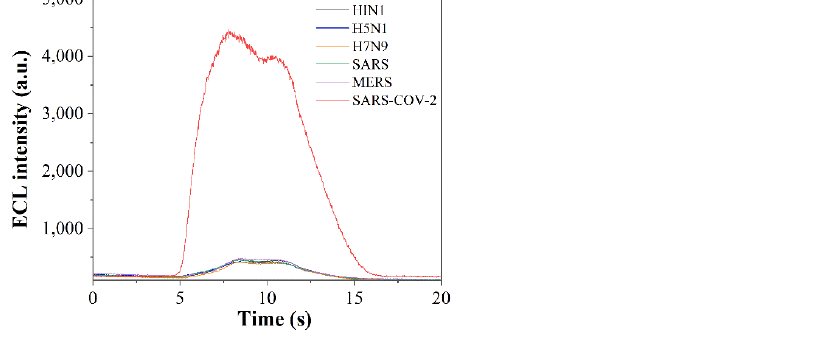
Figure 5. Response curves of detecting different viruses using an ECL biosensor based on dual-probe hybridization.